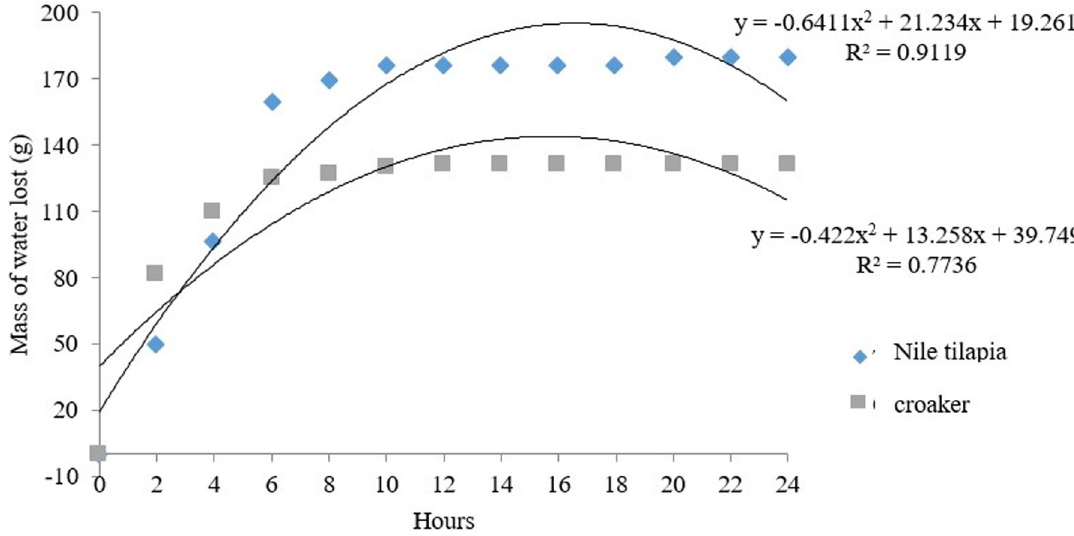
Fig 1. Reduction of Nile tilapia and croaker flours masses during dehydration period. https://doi.org/10.1371/journal.pone.0279351.g001 flours, with salt Nile tilapia flour having significantly lowest levels of calcium and phosphorus, while sweet croaker had the highest levels ( Table 5 ). pH and aW of seasoned flours. The fish specie did not influence the pH value of the elab- orated flours, whose values were 7.06 Nile tilapia and 7.02 croaker. However, when these flours were seasoned, the sweet (7.71) had a higher pH value than the salty (6.37) ( Table 5 ). When analyzing aW of the flours, it can seen in Table 5 that there was an interaction for species and flavoring of the flours. Salted Nile tilapia flour had significantly higher aW 0.44 and sweet Nile